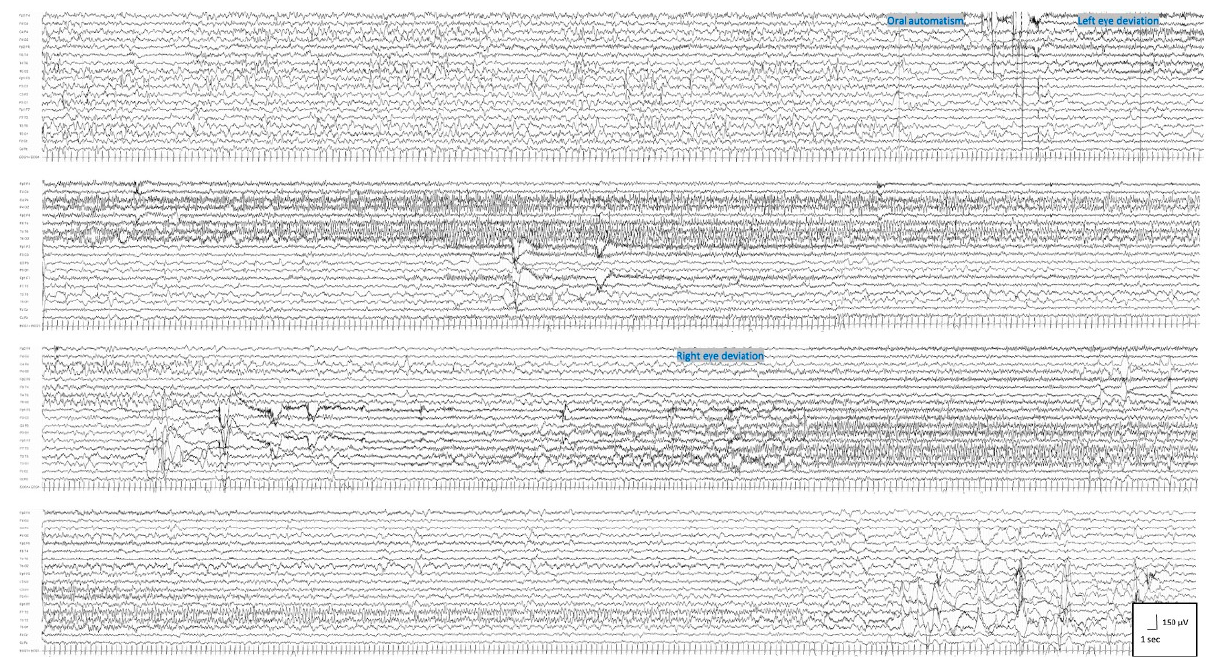
Figure 3. Ictal EEG pattern in Patient #2 at the age of 4 months: seizure started with a flattening in the right fronto-central region, spreading throughout the right hemisphere and migrating to the left hemisphere after around 150 s. The ictal discharge ends in left fronto-temporal region 360 s after its beginning. Clinically, this seizure occurred while awake and is characterized by oral automatisms followed by left eye deviation after 90 s followed by right eye deviation 240 s after its beginning, as shown in the figure. Filters: high pass, 0.01 Hz; and low pass, 35 Hz.